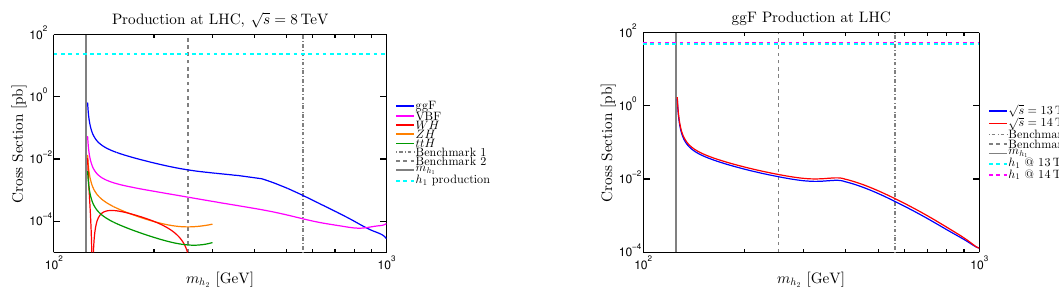
Figure 7 . Cross section at the LHC. The vertical grey dashed lines correspond to the value of m h in our benchmarks. The left panel shows the cross sections computed for p panel is for s = 13 and 14